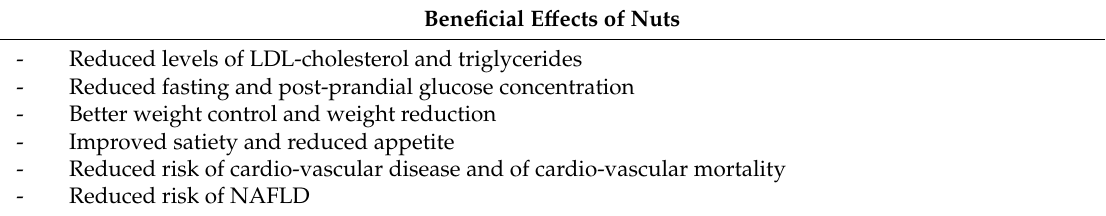
Table 1. Beneficial e ff ects of